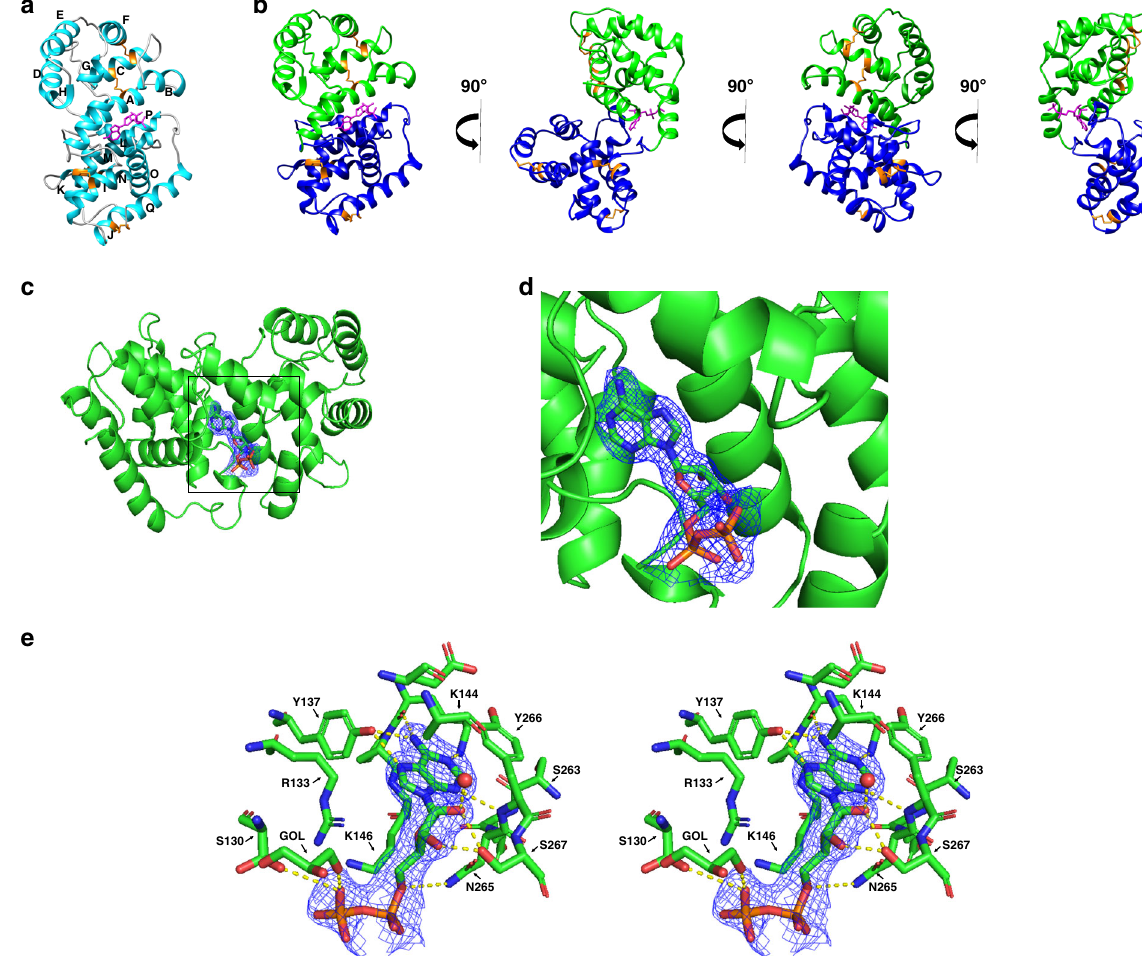
Fig. 4 Structure of CxD7L1 in complex with ADP. a Ribbon representation of CxD7L1-ADP structure. The 17 α -helices are labeled A – Q. b Several views of CxD7L1 differing by rotations of 90° around the y -axis. N-terminal and C-terminal are colored in blue and green, respectively. ADP is shown as a stick model in magenta and disul fi de bonds in orange. c Electron density map covering ADP. CxD7L1 protein is colored in green. d Inset from ( c ) is shown. Amino acid residues of CxD7L1 involved in ADP binding are colored in green ( e ). Stereo view of the binding pocket of the CxD7L1-ADP complex showing the 2 F o − F c electron density contoured at 1 σ covering the ligand. All residues within a 3.6 Å distance from the ADP are shown. Hydrogen bonds are colored in yellow. GOL-402 is a glycerol molecule that is in the area of the phosphate group. R271 was not included in the fi gure as it is not within 3.6 Å and it binds N265, but it does not bind ADP directly.